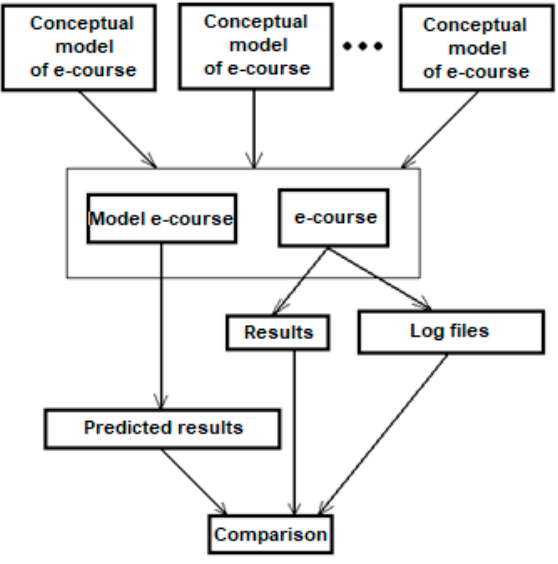
Figure 2. Conceptual model.